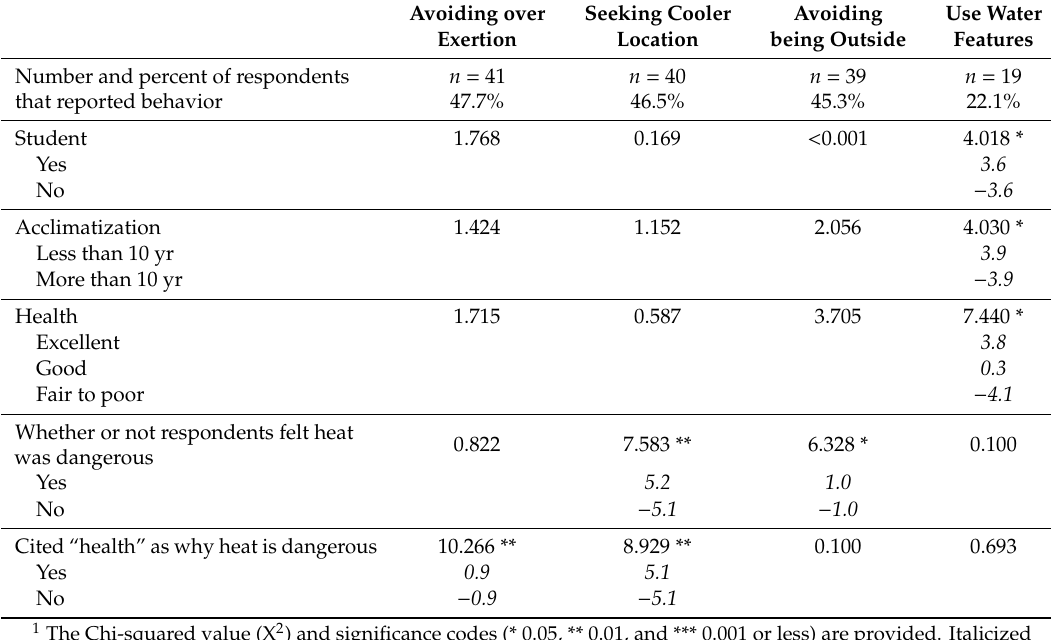
Table 5. Percent of respondents that reported behaviors and Chi-squared results for the associations between reported behaviors and personal characteristics and perceptions 1 .